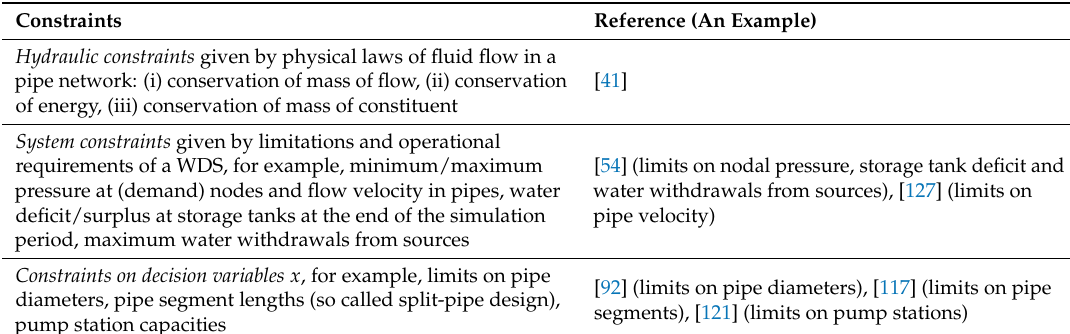
Table 2. Constraints of a general optimisation model.